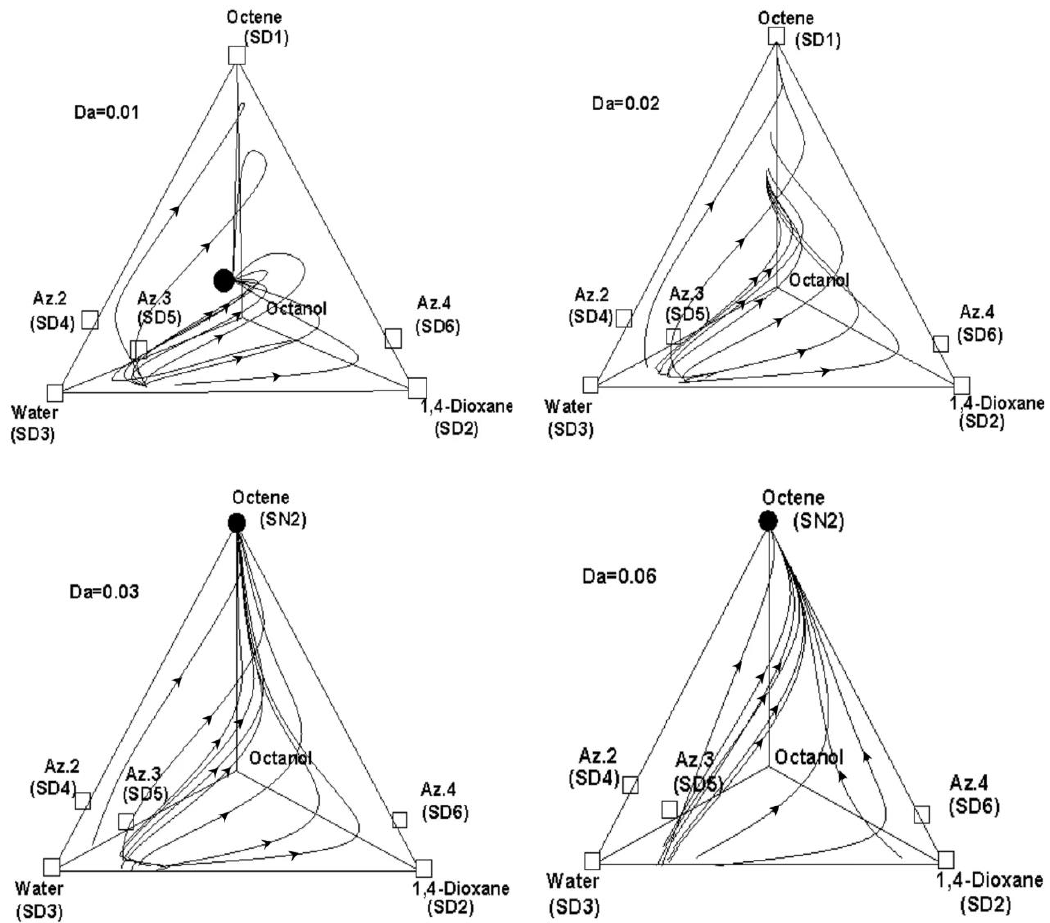
Figure 9. Residual curve of 1-octene hydration reaction with different Da values (1 atm).